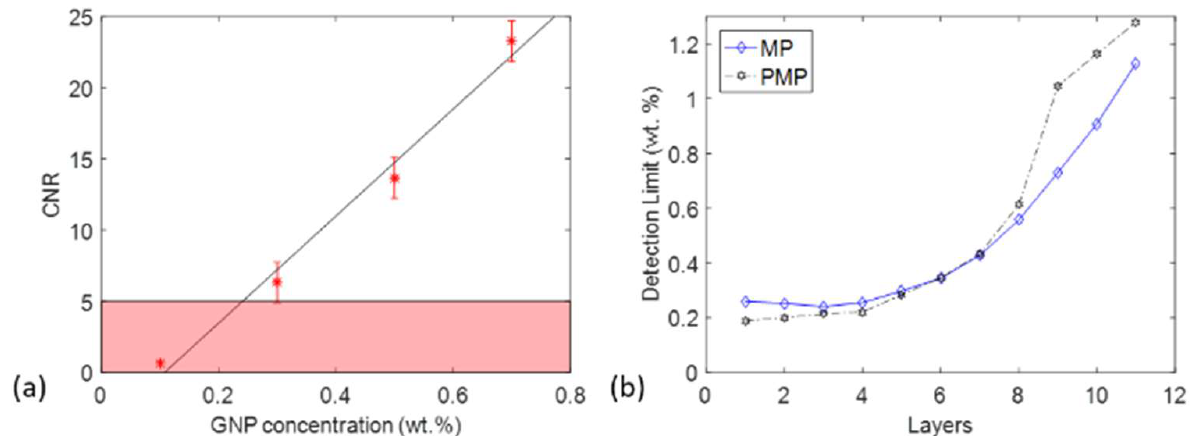
Figure 3. ( a ) CNR as a function of GNP concentration for the third layer of MP geometry; ( b ) detection limit of two geometries in different layers. The shaded area represents CNR < 5, which was considered to be below the detection threshold. The intersection of the linear fit with the shaded region represents the detection limit under that condition.